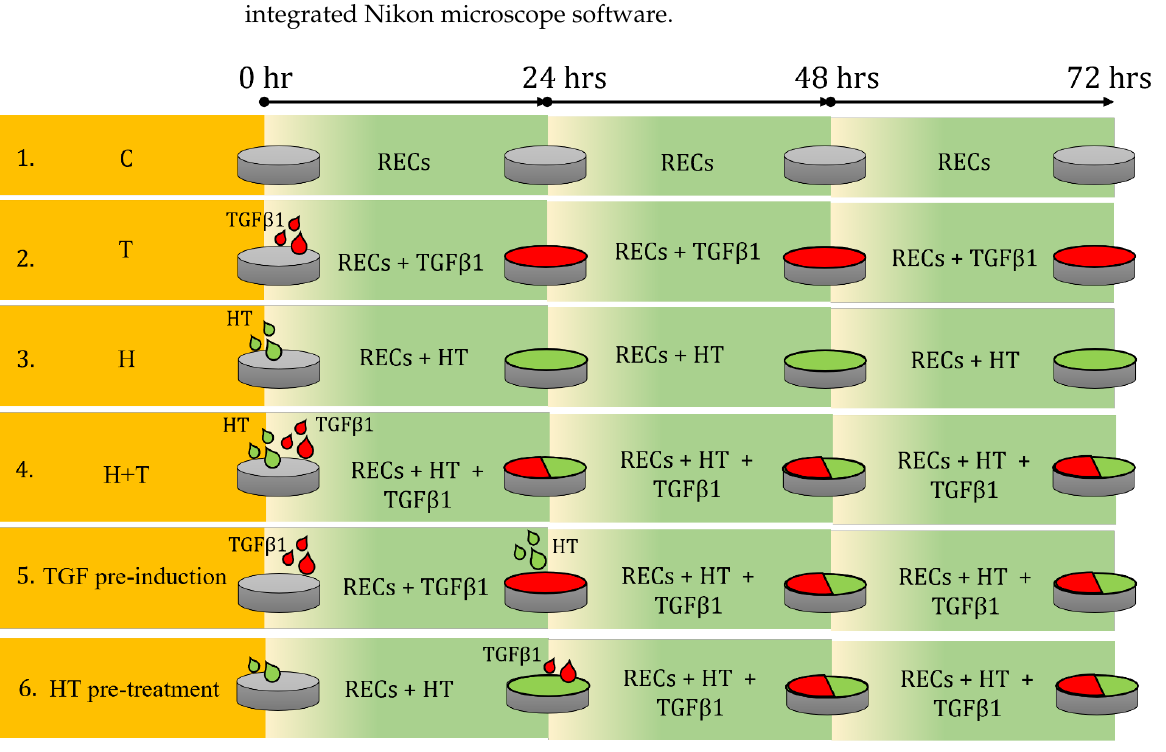
Figure 8. Illustration of experimental design of HT treatment of RECs. Six groups of HT and TGF β 1 treatment conditions are shown. C = Control (untreated RECs), T = TGF β 1, and H = hydroxytyrosol.